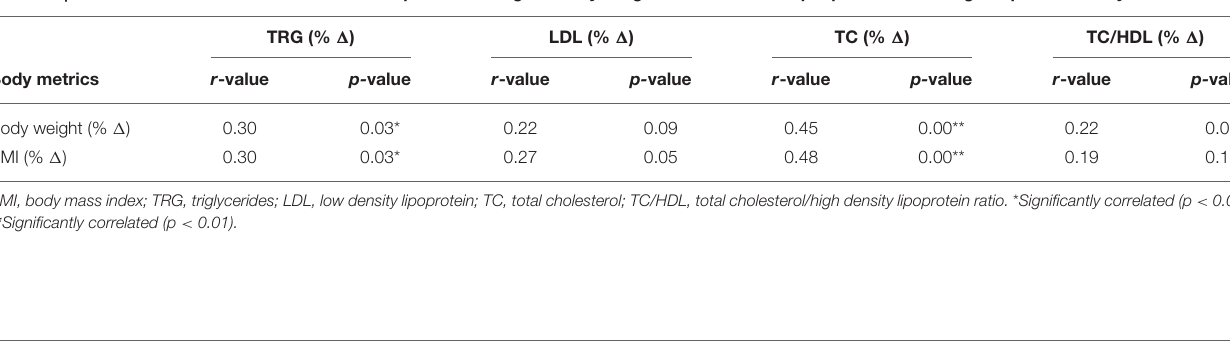
Frontiers in Physiology |